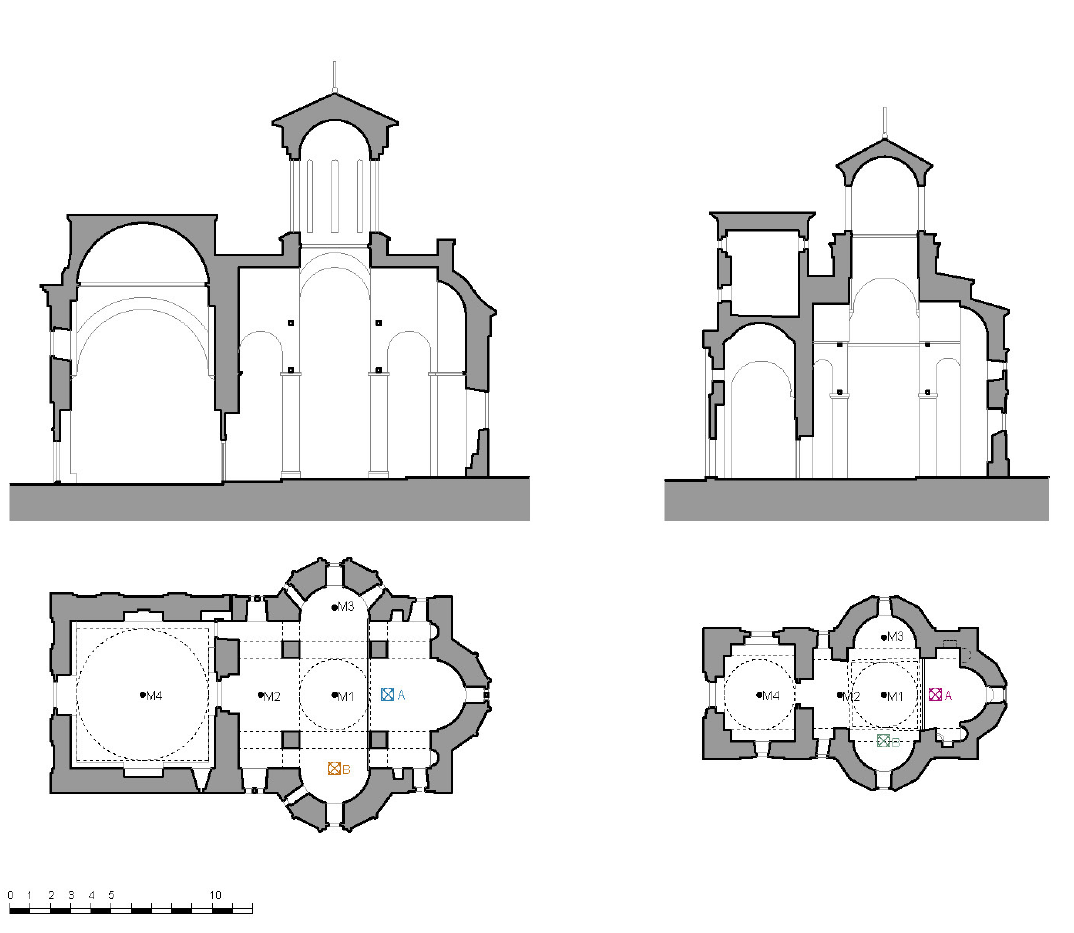
Figure 3. The plan and longitudinal section of Ljubostinja (on the left) and Naupara monastic church (on the right) with marked positions of sound sources (A – in the altar, B – in the southern chanting apse) and measurement points (M1 – under the central dome, M2 – west side of naos, M3 – northern chanting apse, M4 – centre of the